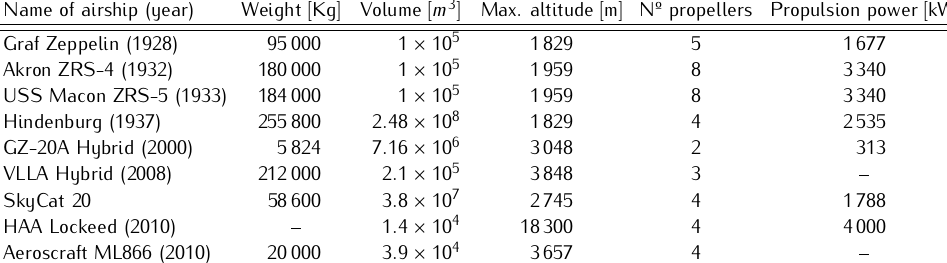
Table 1. Characteristic parameters of airships over the